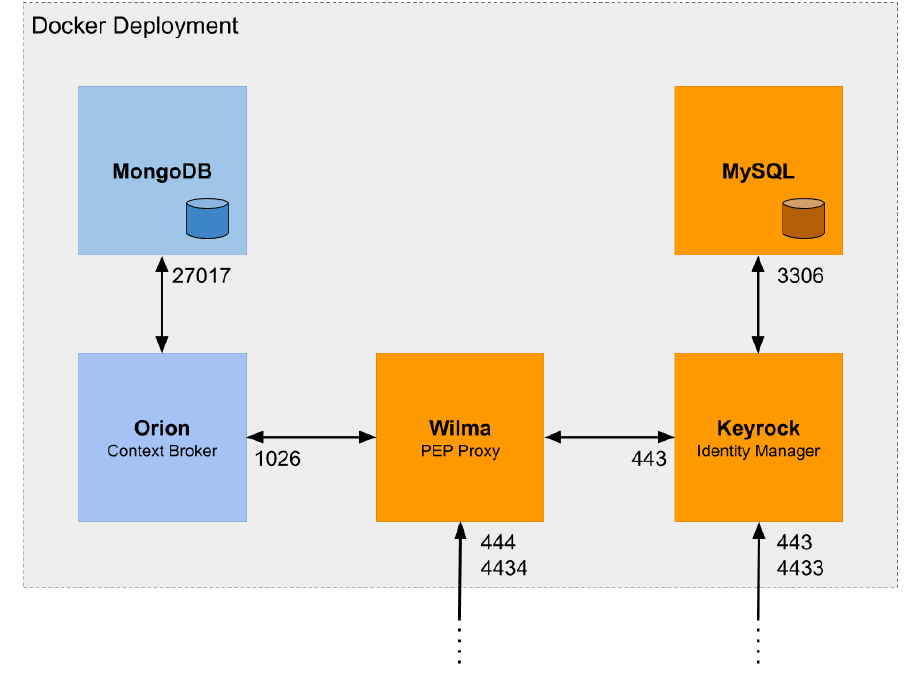
Figure 2. Docker deployment of Generic